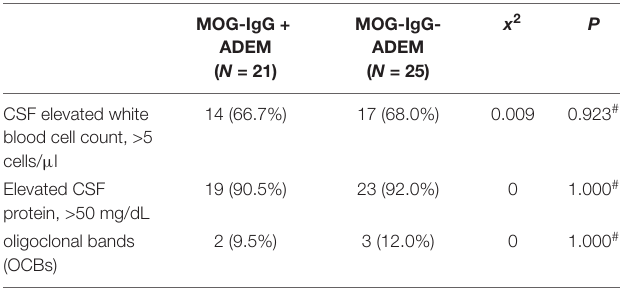
TABLE 2 | Laboratory values of cerebrospinal fluid (CSF) in ADEM children with or without myelin oligodendrocyte glycoprotein-immunoglobulin G (MOG-IgG).